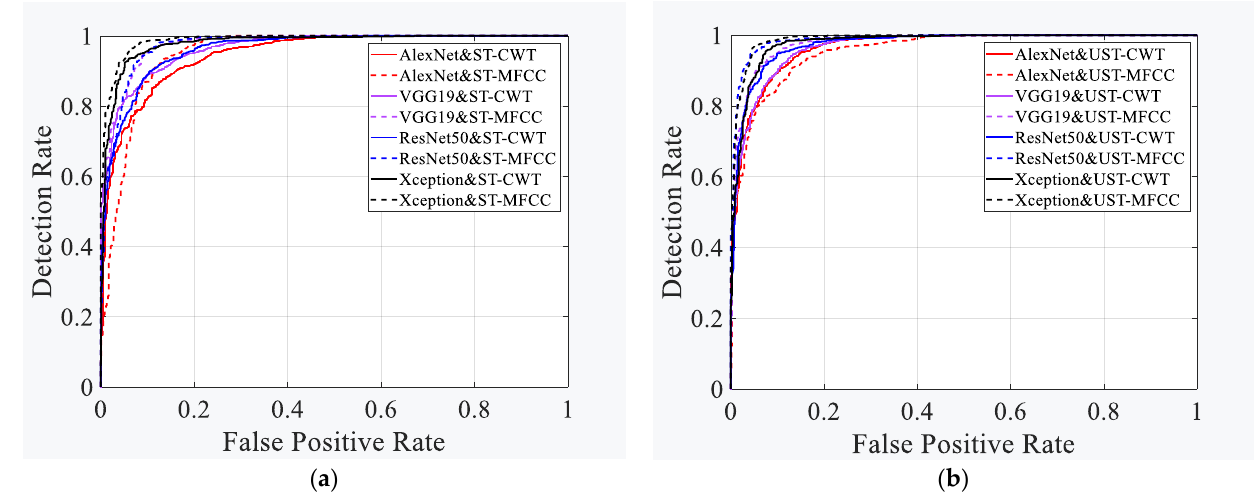
Figure 8. Performance comparison of different neural network models. ( a ) ST-CWT dataset, ( b ) ST-MFCC dataset.